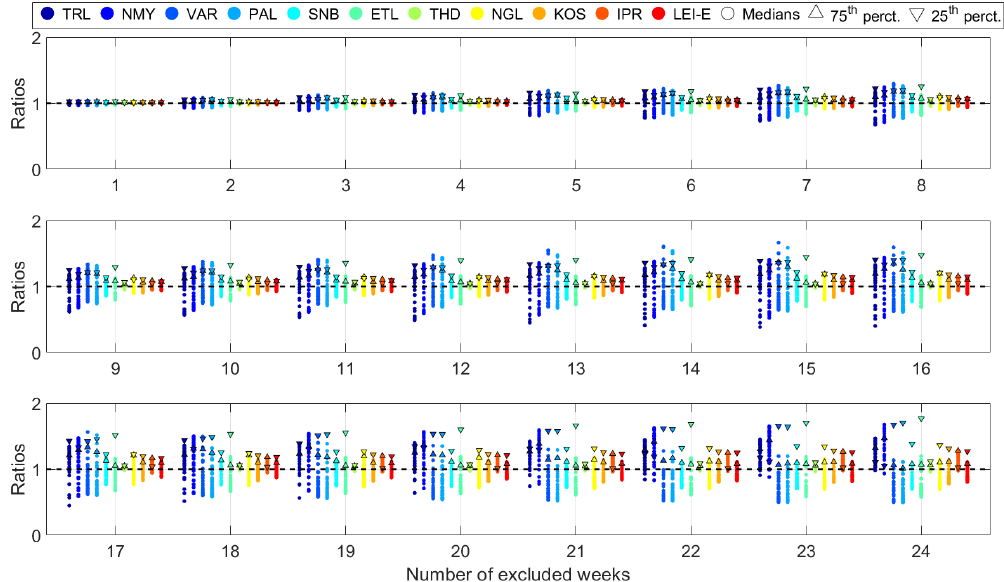
Figure 3. Variability of N tot annual statistics in reduced datasets. For each investigated gap length (between 1 and 24 consecutive weeks), all possible combinations were tested, and in each case the ratio between the newly derived median of N tot and that derived from the original dataset was calculated (circles). The upward and downward triangles provide insight into the range of variability. The triangles facing up represent the ratio between the maximum value of the 75th percentile of N tot obtained from the reduced datasets and the 75th percentile calculated from the original time series. The triangles facing down represent the 25th percentile from the original dataset divided by the minimum of the 25th